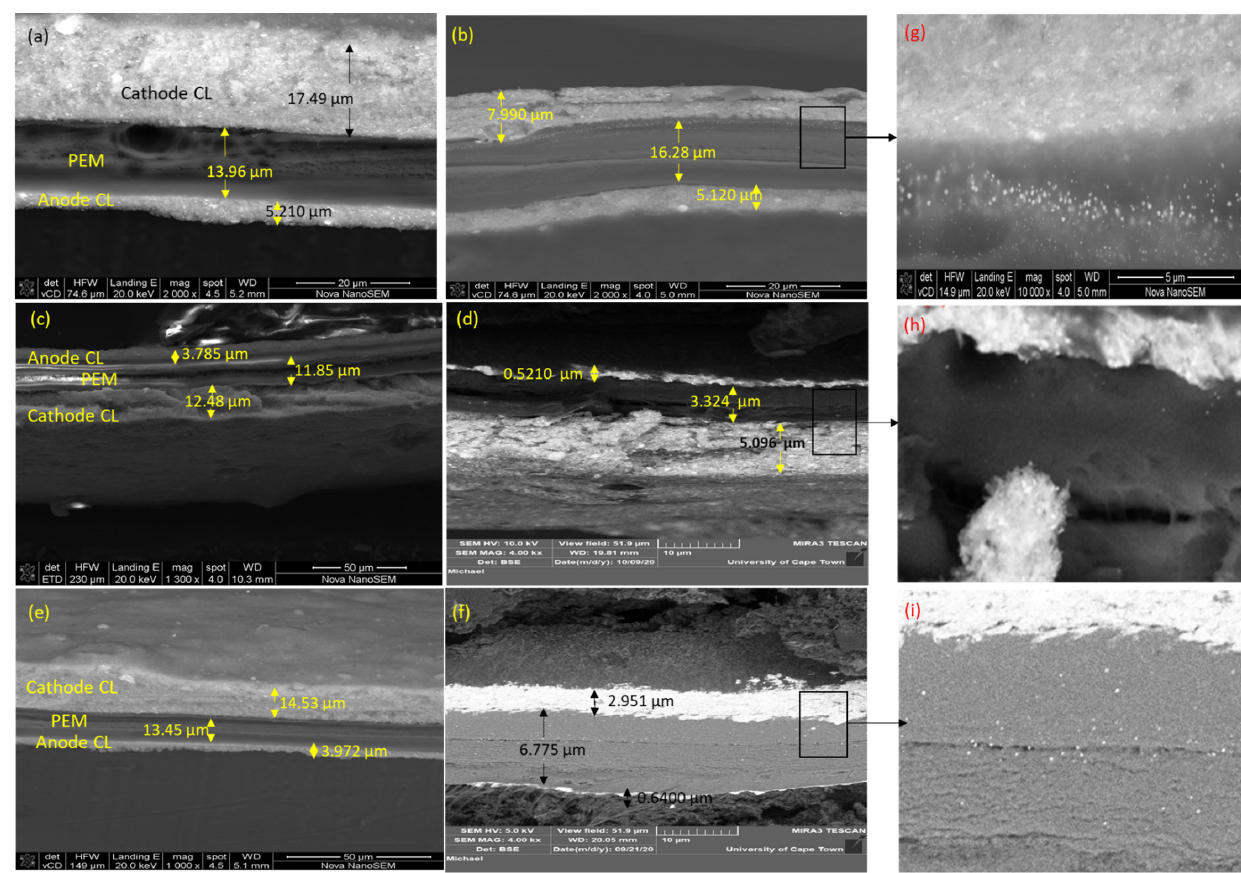
Figure 5. Cross-sectional images of an unused ( a ) CCL MEA #1M; ( c ) CCL MEA #2M; ( e ) CCL stratified MEA #6. After the carbon corrosion test, SEM images of the degraded ( b ) MEA #1M, ( d ) MEA #2M, and ( f ) MEA #6 were captured. Magnified images of the degraded ( g ) MEA #1M, ( h ) MEA #2M, and ( i ) MEA #6 show that Pt migrated from the CL into the PEM. Table 5. The thicknesses of MEAs before and after the carbon degradation